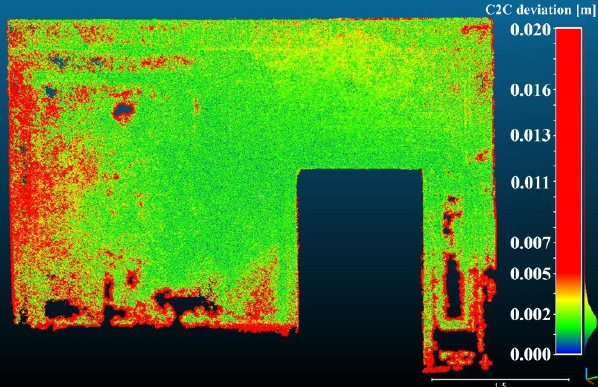
Figure 12. Comparison of the points cloud difference between Canon and Hasselblad